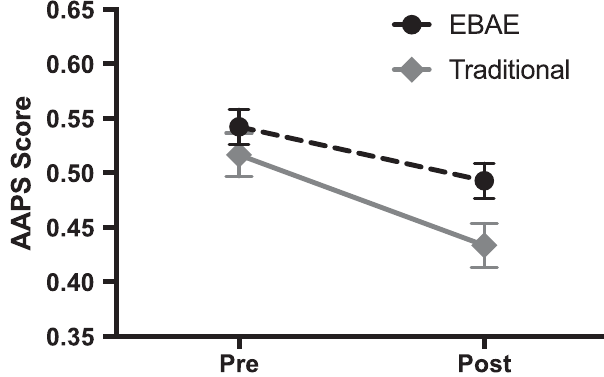
FIG. 1. Raw normalized data (i.e., without controlling for presurvey scores) show the overall average scores for both the pre- and post-AAPS survey in the calculus-based first semester classes. The error bars represent standard